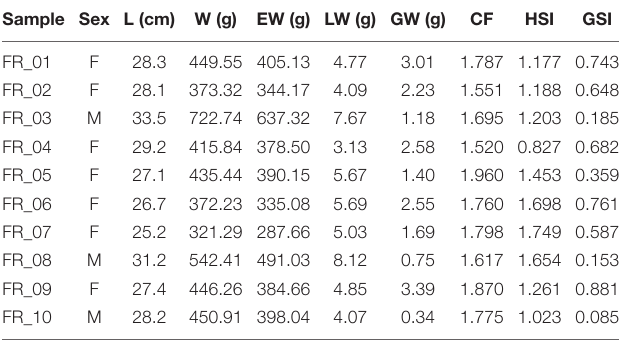
TABLE 1 | Sampling information on sex, morphometry, and bioenergetic/reproductive